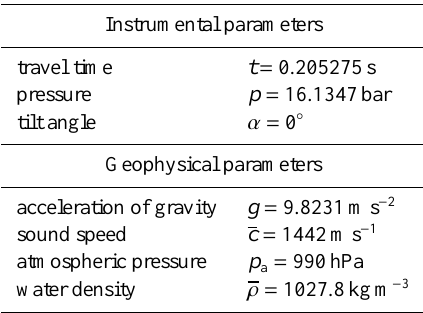
Table 2. Absolute values used for the sensitivity